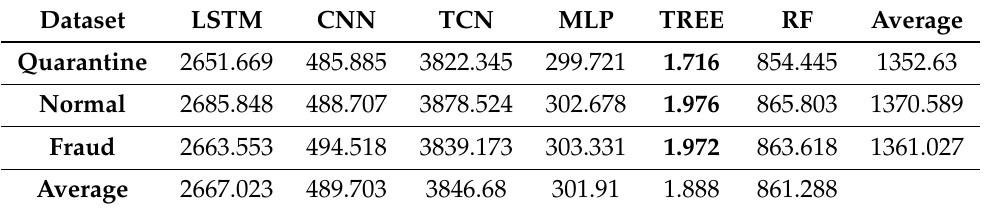
Table 14. Total time in seconds for training and validation of each of the